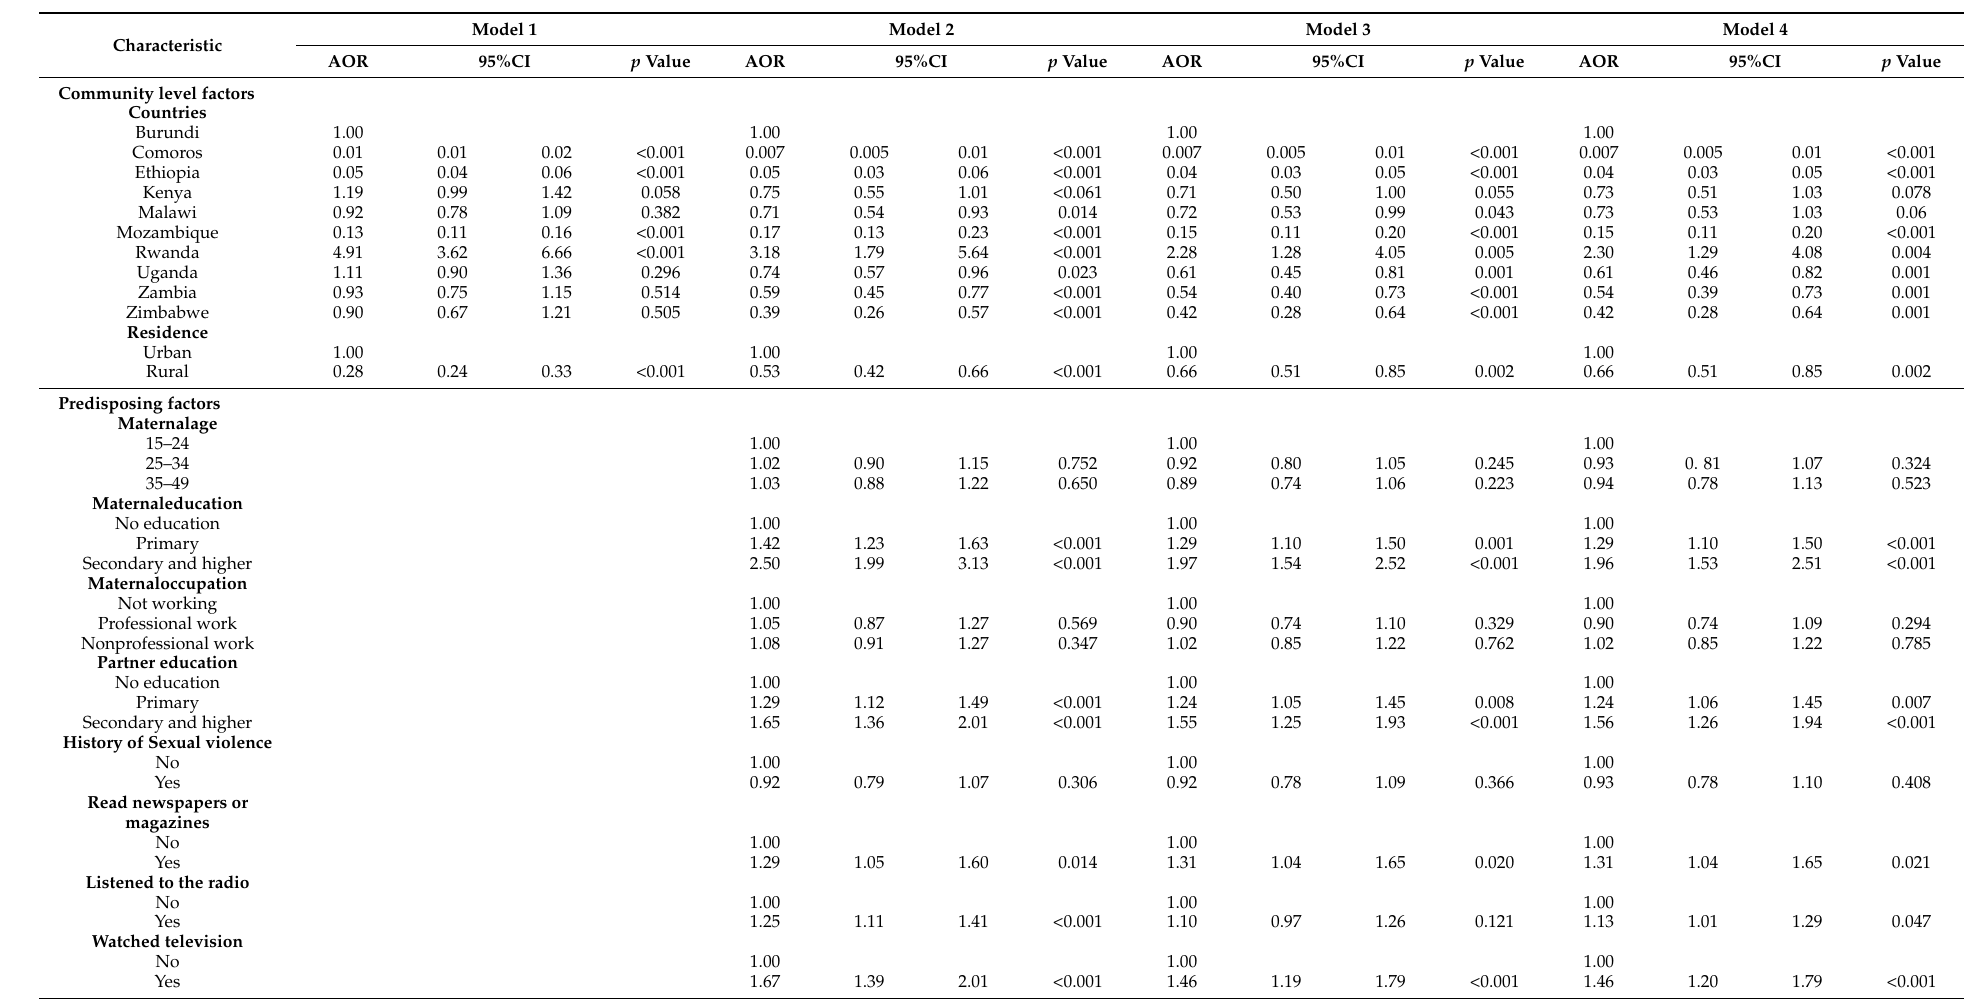
Table 2. Factors associated with prenatal HIV testing for PMTCT of HIV in East African countries (DHS,